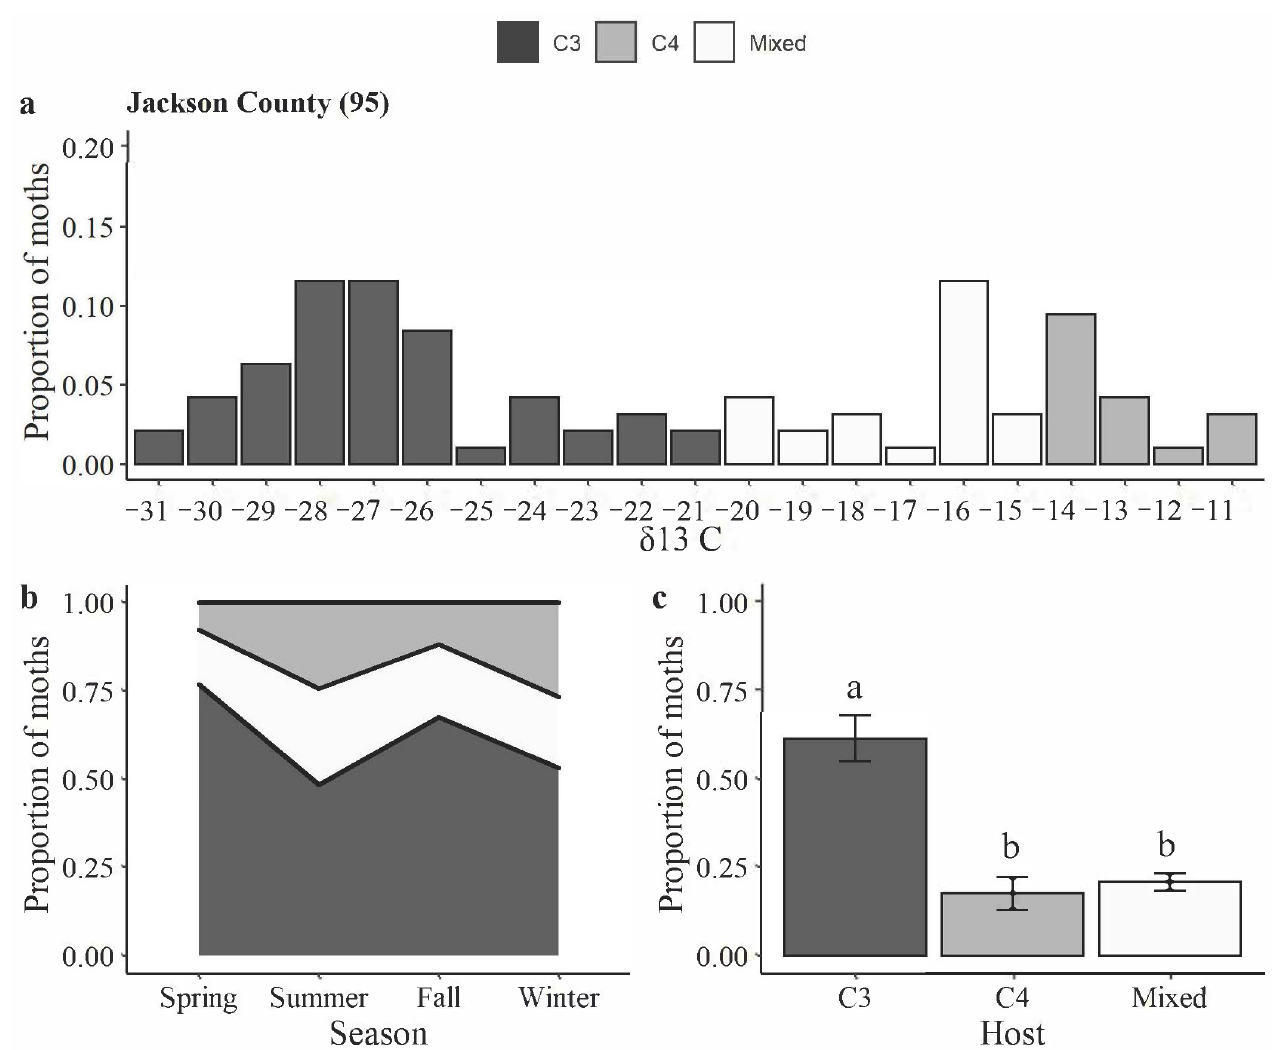
Figure 2. Carbon isotopic analysis of H. zea moths trapped in commercial fields in Jackson County: ( a ) distribution of δ 13 C values from H. zea wings ( y -axis indicates the proportion of samples with a given δ 13 C value); ( b ) proportion of insects developed on C3, C4, or mixed (both C3 and C4) host plants over the seasons; and ( c ) proportion of insects developed on C3, C4, or mixed host plants. Bars with the same letters are not significantly different ( p > 0.05, Wilcox test).